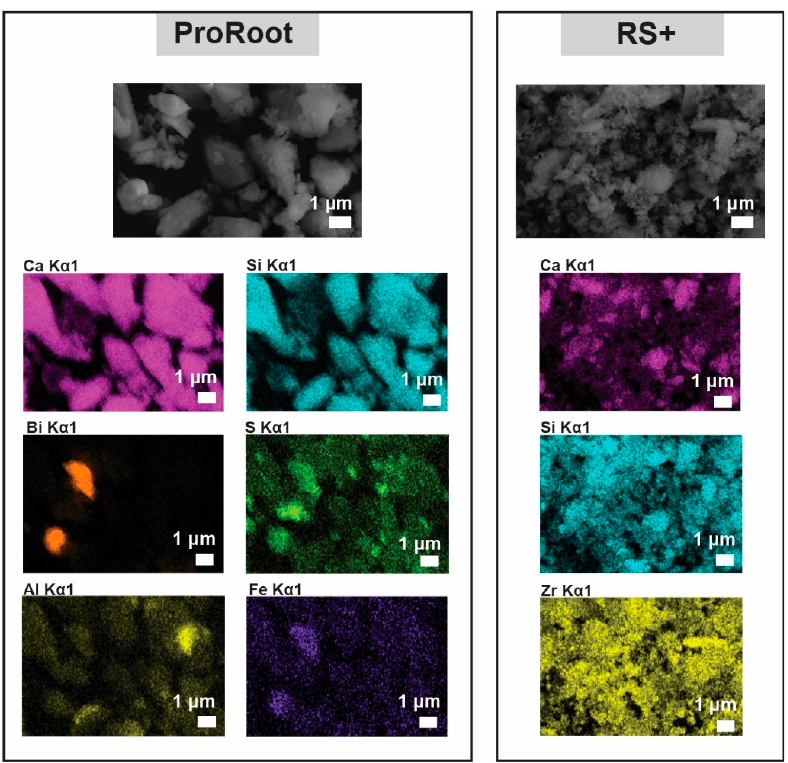
Figure 4. SEM-EDS mapping of the as-received powders showing elemental distribution.